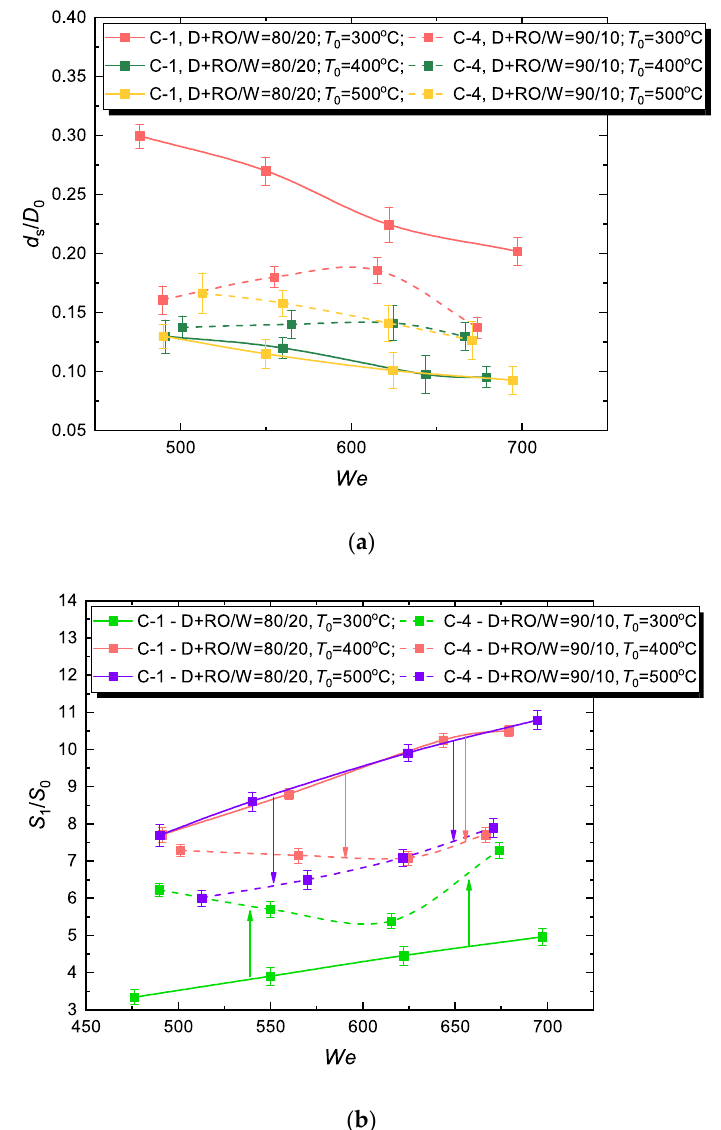
Figure 11. Effect of water concentration in WiBDME (C-1 and C-4) on hydrodynamic disintegration characteristics of corresponding fuel droplets (mean diameter of child droplets ( a ) and fuel evaporation surface area ( b ) at various surface temperatures).